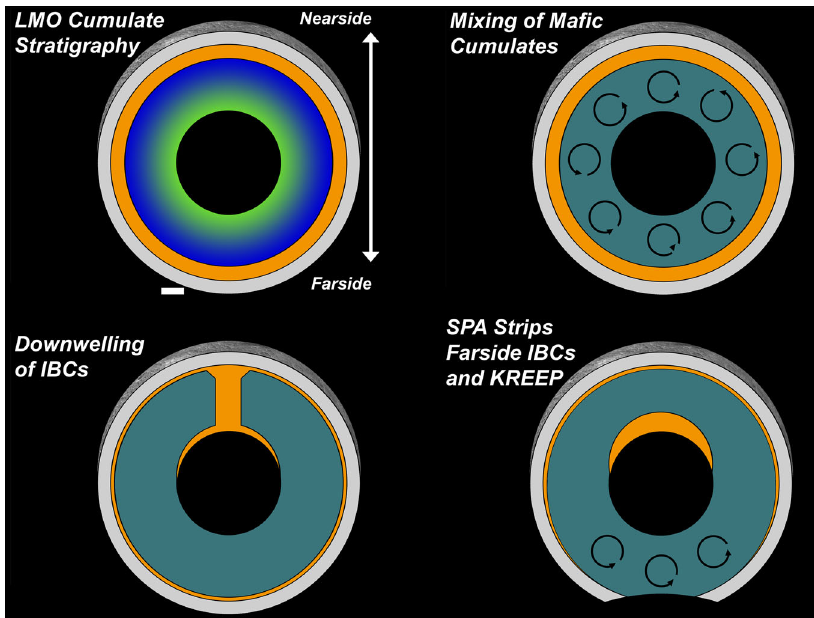
Fig. 2 The evolution of the lunar interior through time. As mentioned in Fig. 1, the predicted Lunar Magma Ocean (LMO) cumulate stratigraphy (top panel) is never realized at any point in lunar history. Instead, dynamical models and experiments suggest that early ma fi c cumulates become mixed and dense ilmenite-bearing cumulates (IBCs) sink into the lower mantle before magma ocean solidi fi cation is complete (middle panels). Depending on viscosity contrasts between IBCs and the underlying ma fi c mantle, hemispherical downwelling may concentrate IBCs in the nearside mantle, which could be responsible for the dichotomy in thermal and geochemical evolution between the nearside and farside (however, ilmenite rheology estimates suggest this material would instead form a uniform, partially molten layer around the lunar core). Globally, some IBCs and incompatible elements (KREEP) are expected to remain in the upper mantle but may be stripped from the farside by South Pole – Aitken Basin (SPA) excavation and localized convection (bottom panel). Layer thicknesses are not to